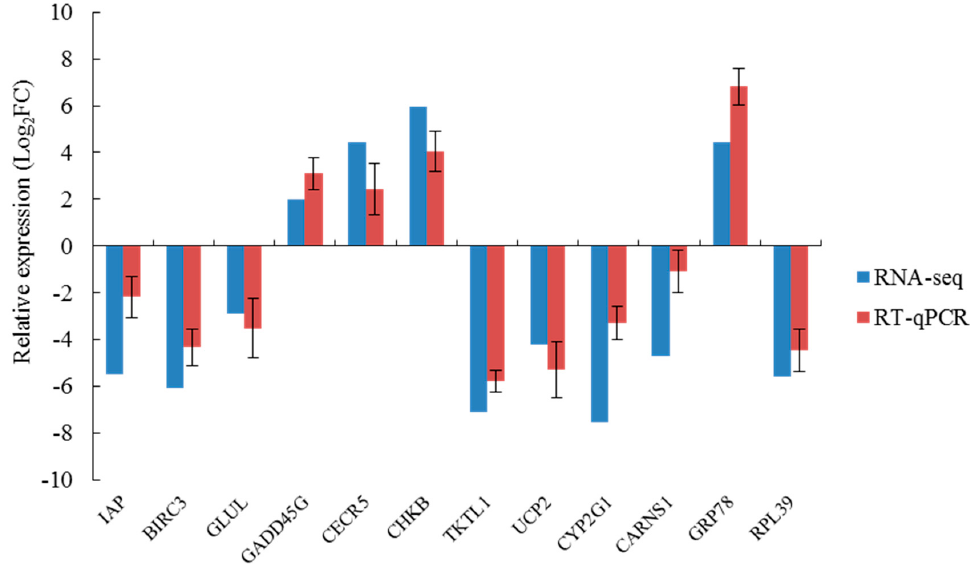
Genes selected for real-time PCR validation and the fold change in three salinity treatments for both RNA-seq and RT-PCR analysis. IAP , inhibitor of apoptosis protein; BIRC3 , baculoviral IAP repeat-containing protein 3; GLUL , glutamine synthetase; GADD45G , growth arrest and DNA damage-inducible protein; CECR5 , cat eye syndrome critical region protein 5; CHKB , choline / ethanolamine kinase; TKTL1 , transketolase-like protein 1; UCP2 , mitochondrial uncoupling protein 2; CYP2G1 , cytochrome P450 2G1; CARNS1 , carnosine synthase 1; GRP78 , glucose-regulated protein; RPL39 , ribosomal protein L39. The relative expression values were normalized to β -actin gene expression. Vertical bars represent the mean ± S.D. ( n = 3).